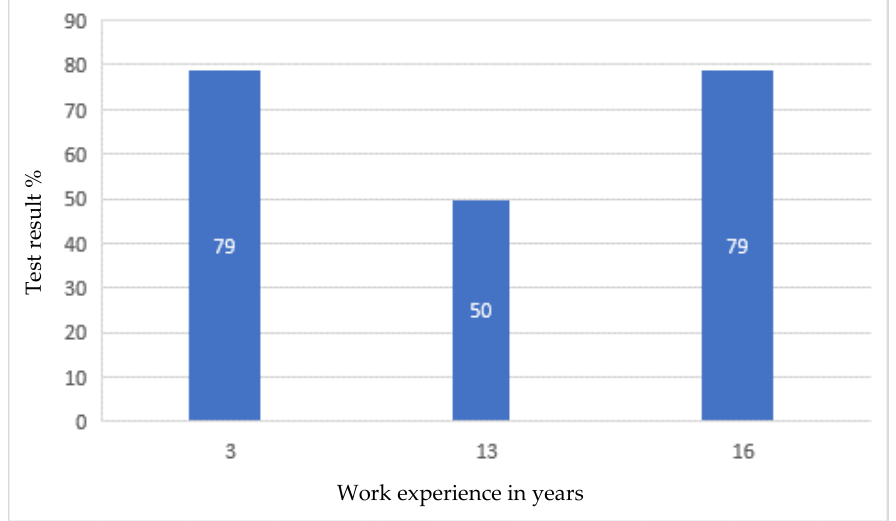
Figure 2. Research results regarding the emergencies of the conveyor belt, depending on profes- sional experience.